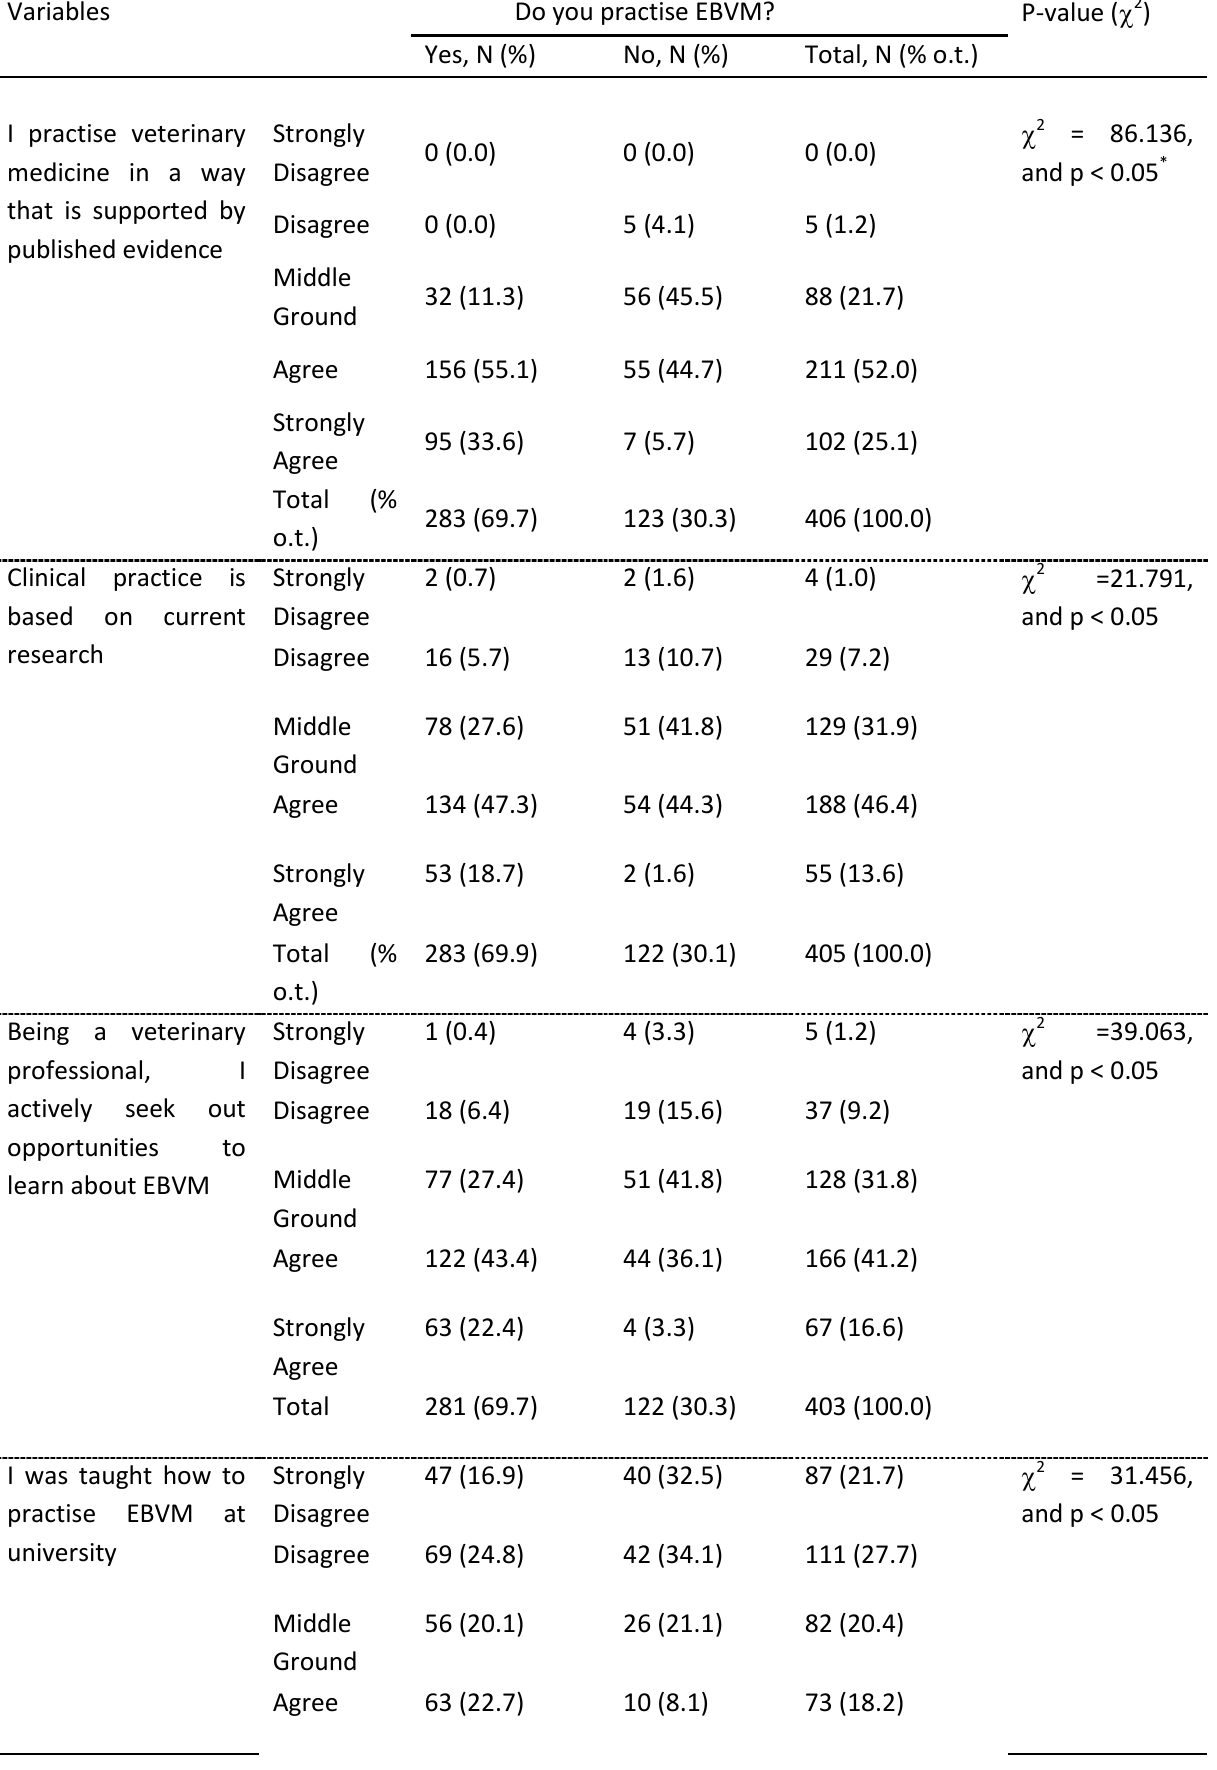
Table 3 : EBVM and clinical practice Variables Do you practise EBVM? P-value (  2